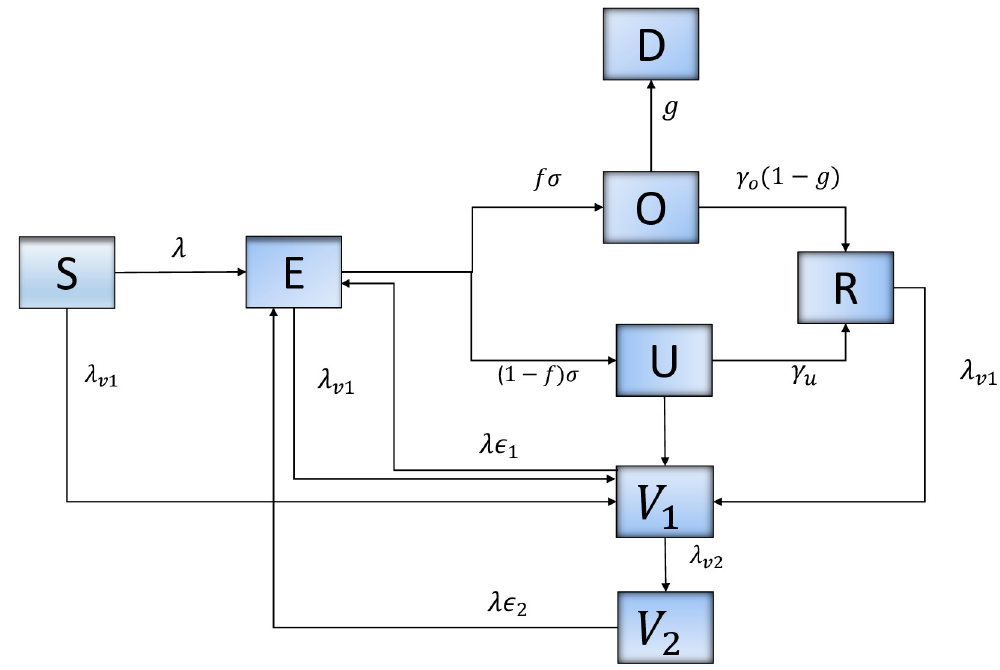
Fig 1. Flow diagram of SARS-CoV-2 transmission dynamics with